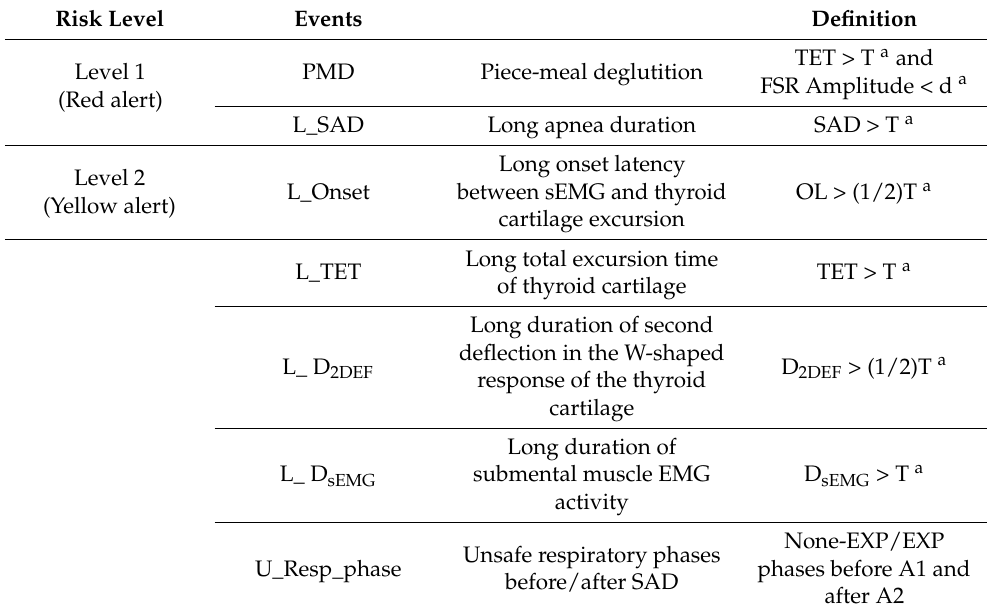
Table 2. Definition of the risk